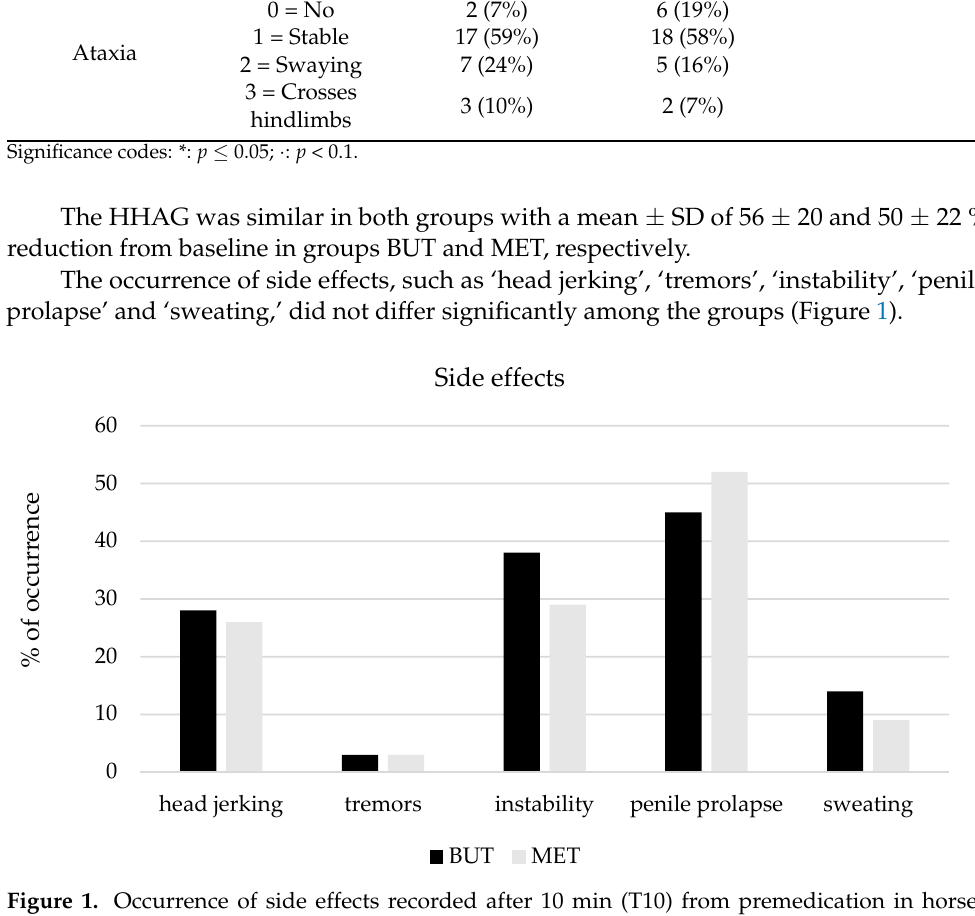
Figure 1. Occurrence of side effects recorded after 10 min (T10) from premedication in horses receiving romifidine and either butorphanol (group BUT, n = 29) or methadone (group MET, n = 31). Physiological parameters were significantly different in all animals at T10 (Table 4) and within time between the two groups (Table 5).